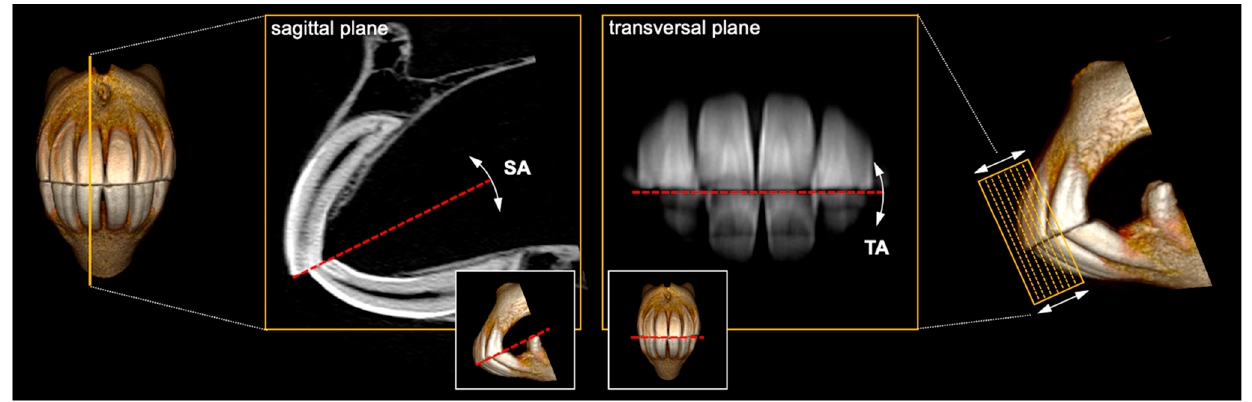
Figure 1. Exemplary depiction of sagittal angle (SA) and transversal angle (TA) constituting the two-dimensionally inclined incisor occlusal surface. SA inclination is shown on a 0.6mm CT section of teeth 101 and 401; TA inclination is shown on a mean intensity projection (MeanIP) thick-slab reconstruction of series of such CT sections, including clinical crown parts of all Triadan 01 and 02.